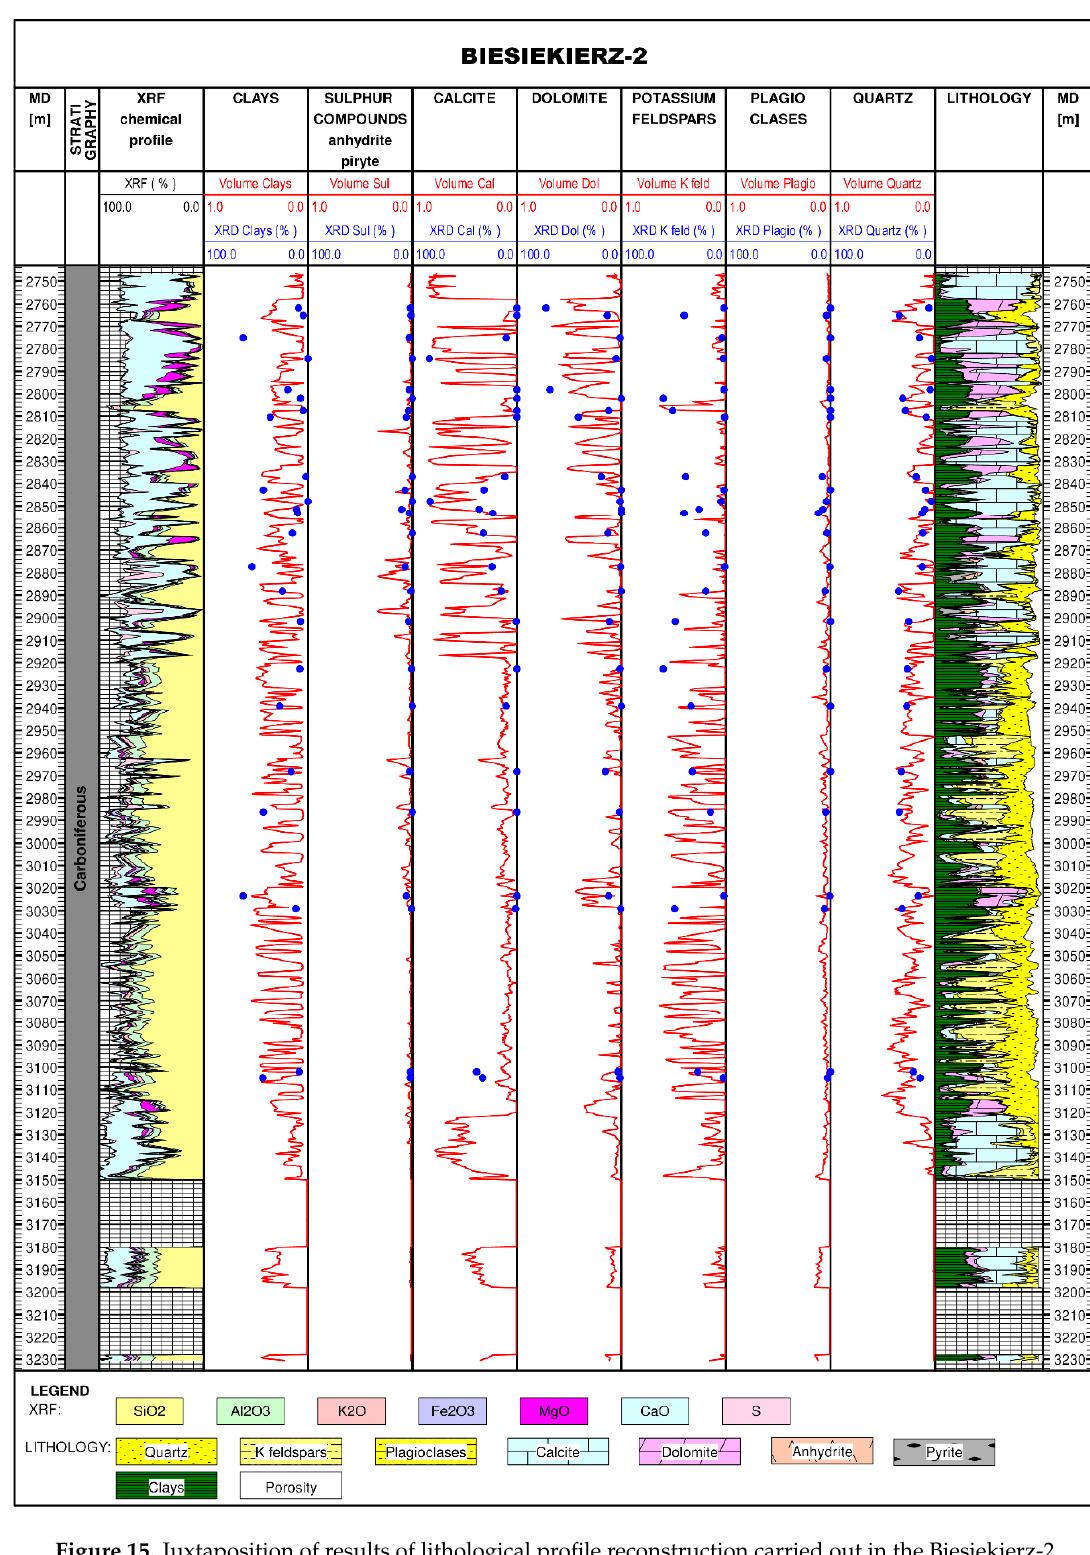
Figure 15. Juxtaposition of results of lithological profile reconstruction carried out in the Biesiekierz-2 borehole with XRD mineral composition measurements.